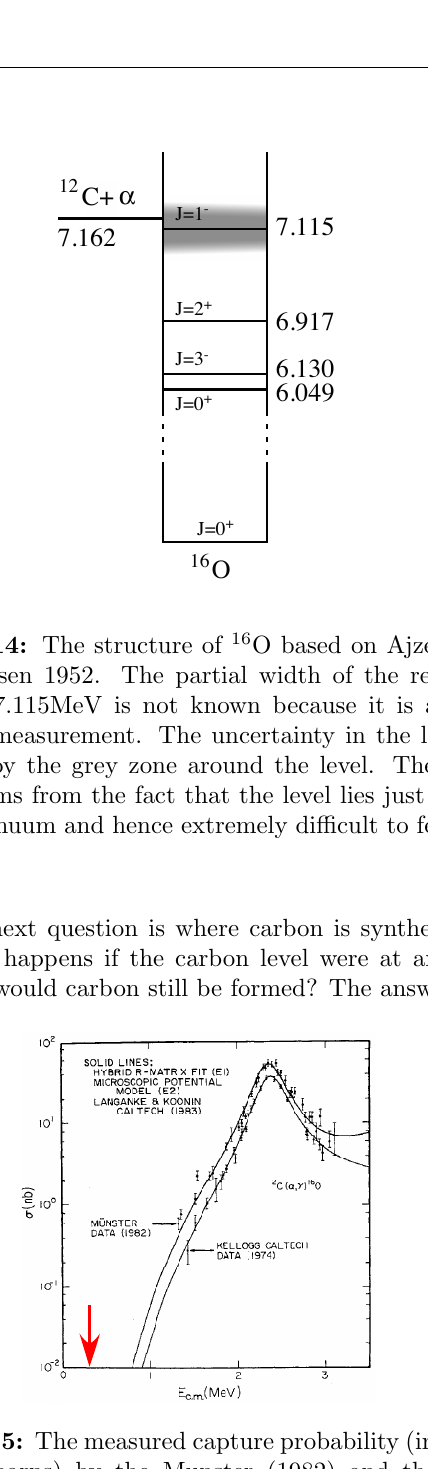
Figure 8.21: The ratio between the newest rate calculated by Kunz et al (2002) and the standard rate compiled by Caughlan and Fowler (1988) used in many calculation of stellar evolution. The ratio is given as a function of the temperature.